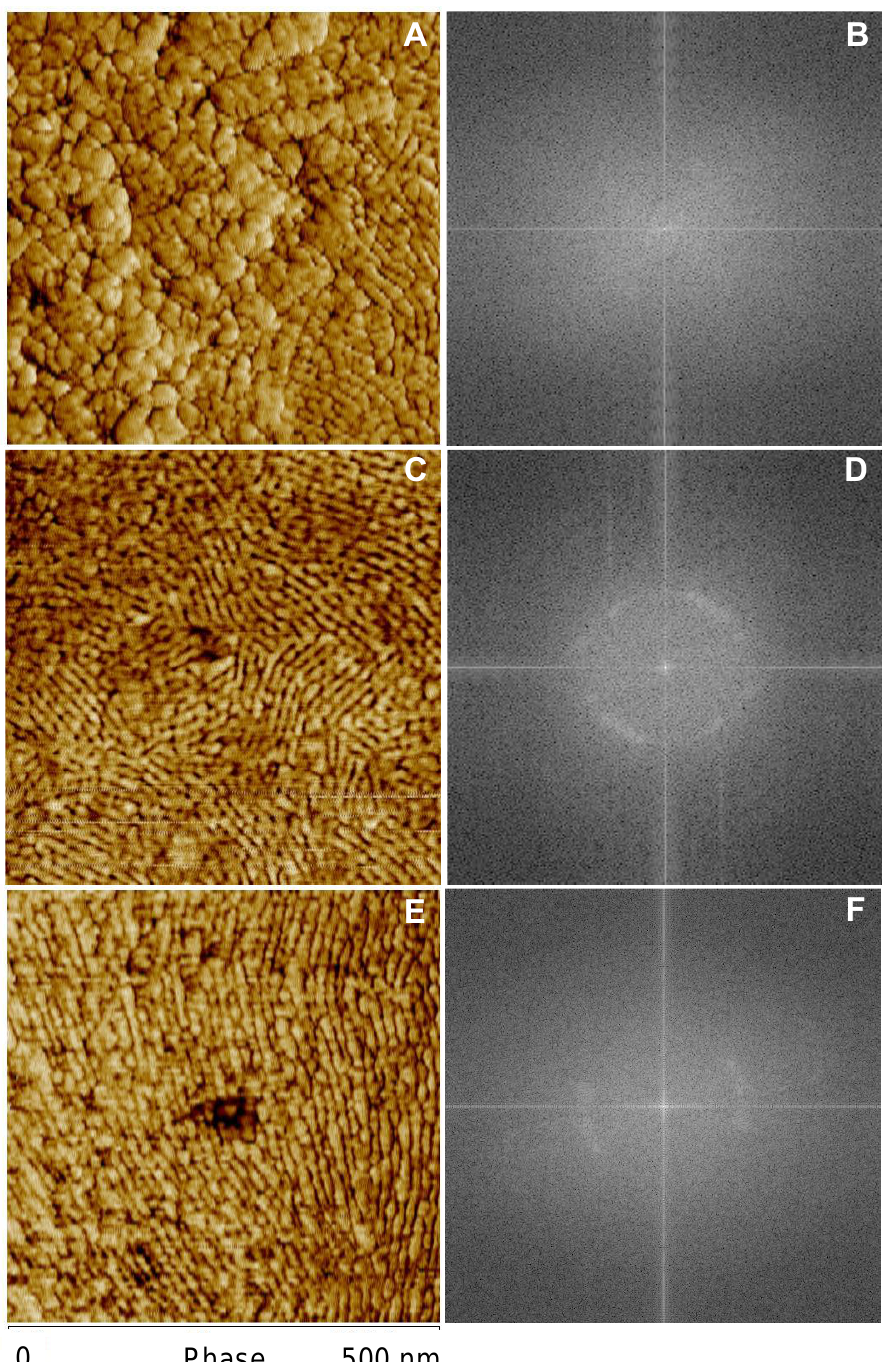
Figure 5. Phase images ( A , C , E ) and corresponding fast Fourier transform (FFT) results ( B , D , F ) taken from two unstretched samples ( A – D ) and one stretched sample ( E , F ) of Arachnocampa tasmaniensis glowworm thread.